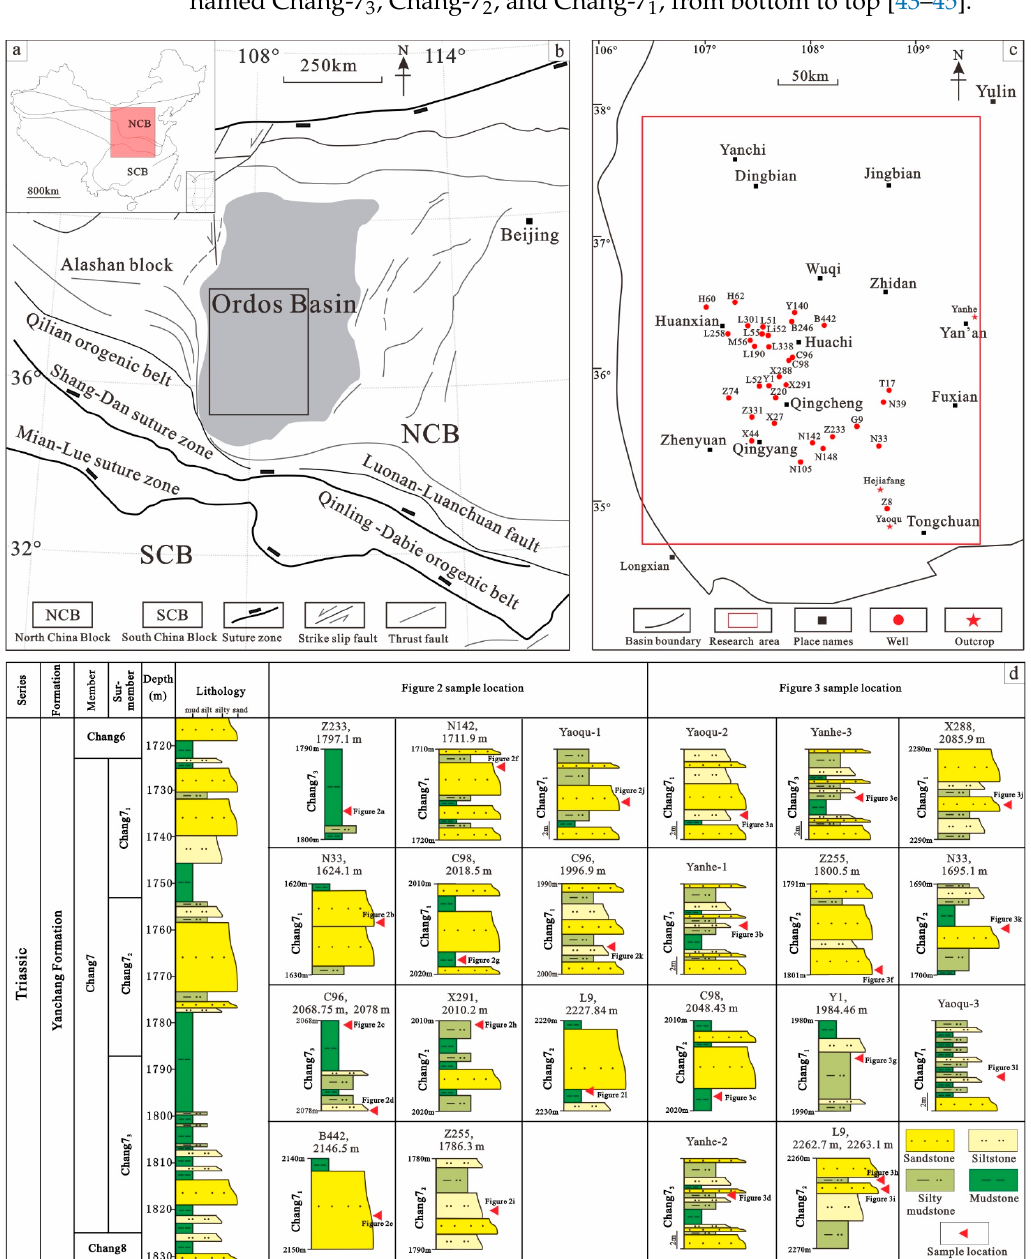
Figure 1. Geological setting ( a , b ), location ( c ), and sample location ( d ) of the study area.